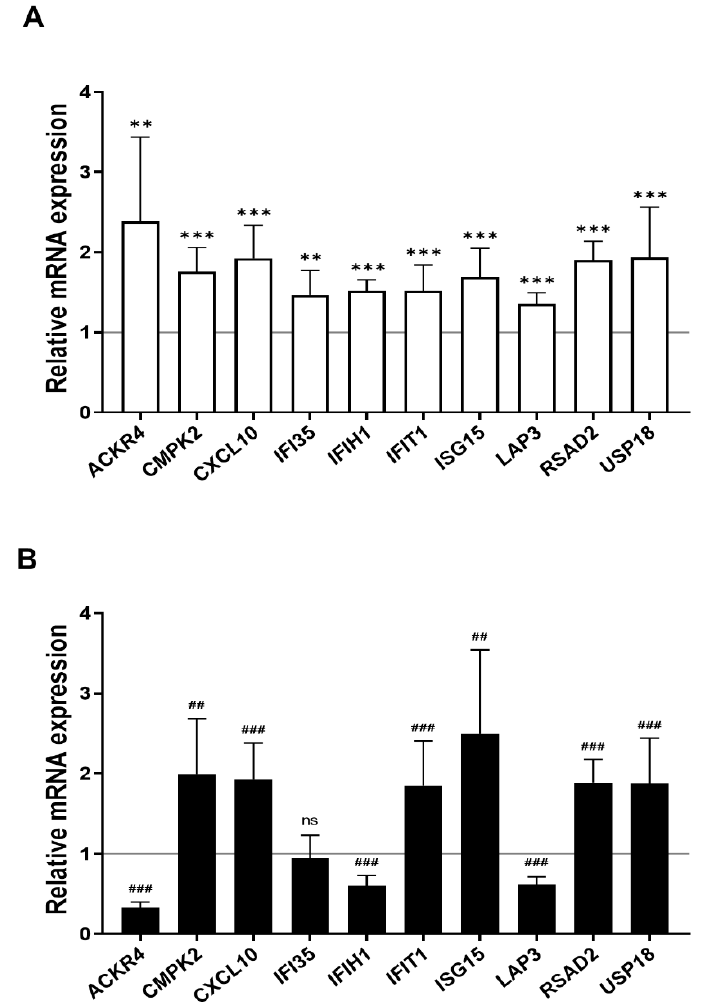
Figure 6. Quantitative PCR validation of common low-dose radiation-responsive genes expressed in HAECs and T2D-HAECs. Values are represented as mean ± SD (n = 6). (A) Related gene expression of normal HAECs by 100 mGy radiation, ** p < 0.01, *** p < 0.005 vs. non-irradiated HAECs by Student’s t -test was considered statistically significant. (B) Related gene expression of T2D-HAECs by 100 mGy radiation, ## p < 0.01, ### p < 0.005 vs. non-irradiated T2D-HAECs by Student’s t -test was considered statistically significant. ns = no significance. Table 3. List of changes in gene expression in HAECs and T2D-HAECs after exposure to 100 mGy radiation.